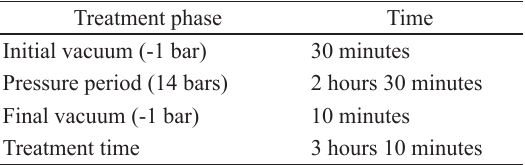
Treatment schedule of the vacuum-pressure process. Treatment